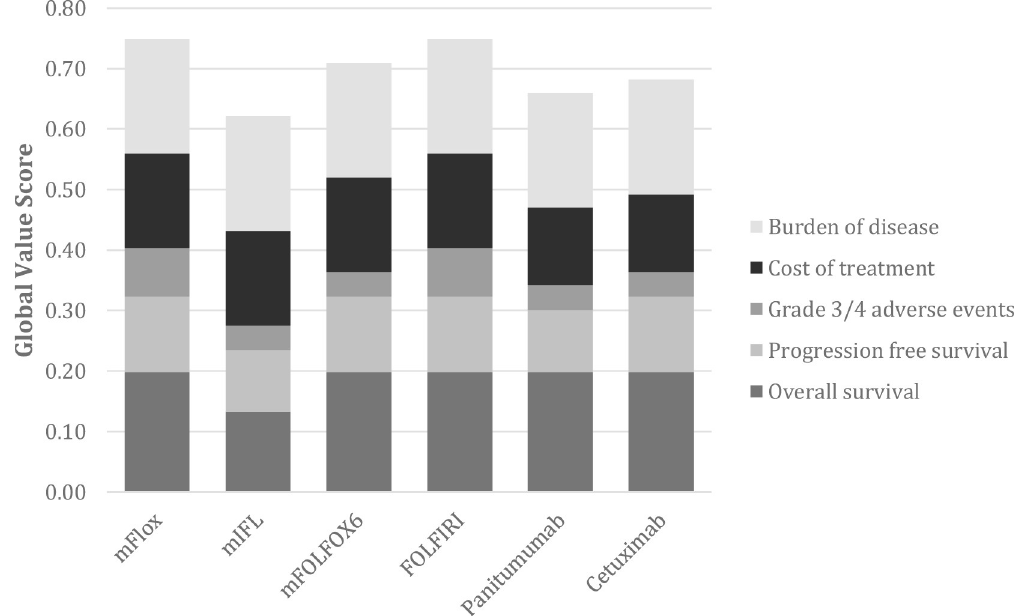
Fig 2. Stacked bar plot of treatments’ weighted global value scores across all criteria. mFlox = 5FU, oxaliplatin, leucovorin; mIFL = irinotecan, 5FU, leucovorin; mFOLFOX6 = 5FU, oxaliplatin, leucovorin; FOLFIRI = 5FU, oxaliplatin, irinotecan,